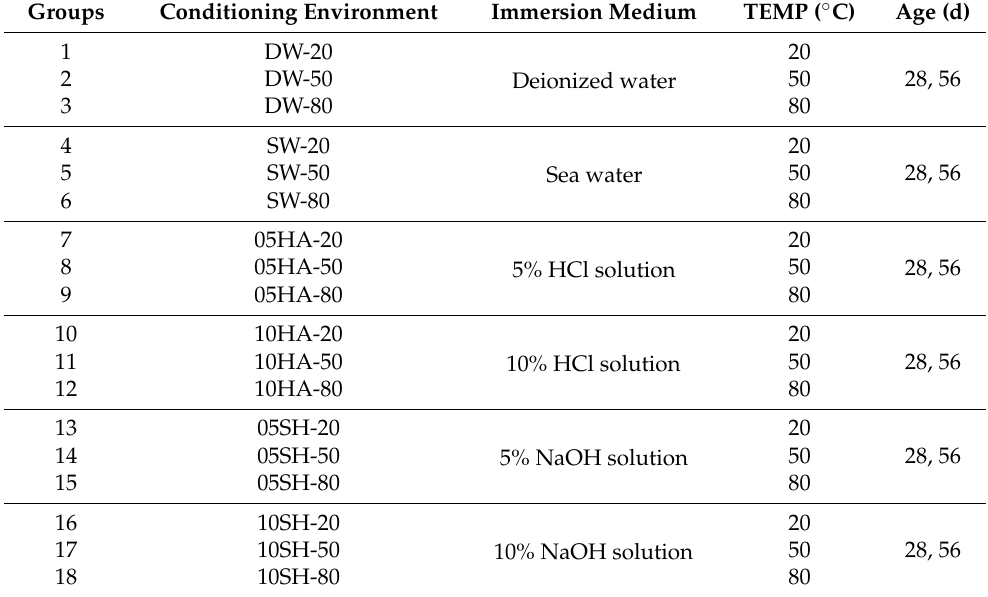
Figure 2. GFRP specimen immersion test. Table 1. Experimental